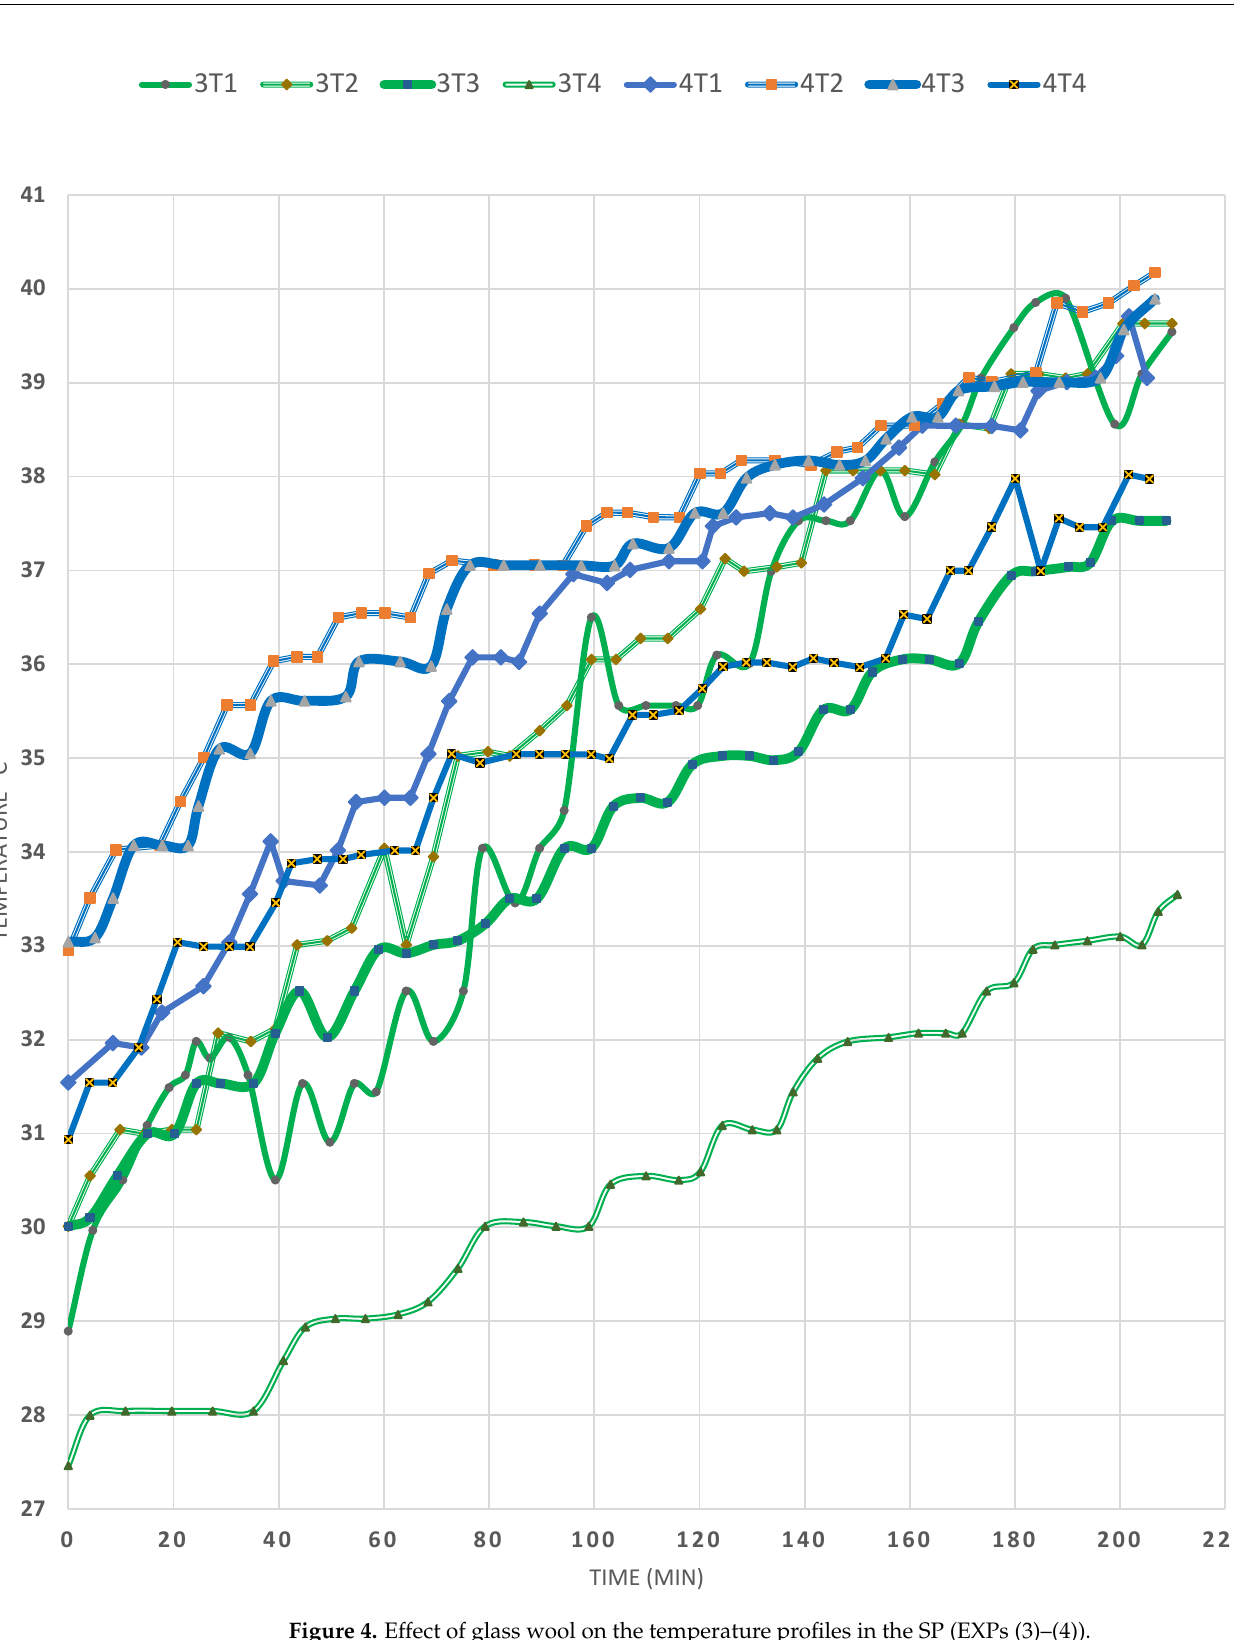
Figure 4. Effect of glass wool on the temperature profiles in the SP (EXPs (3) – (4)).